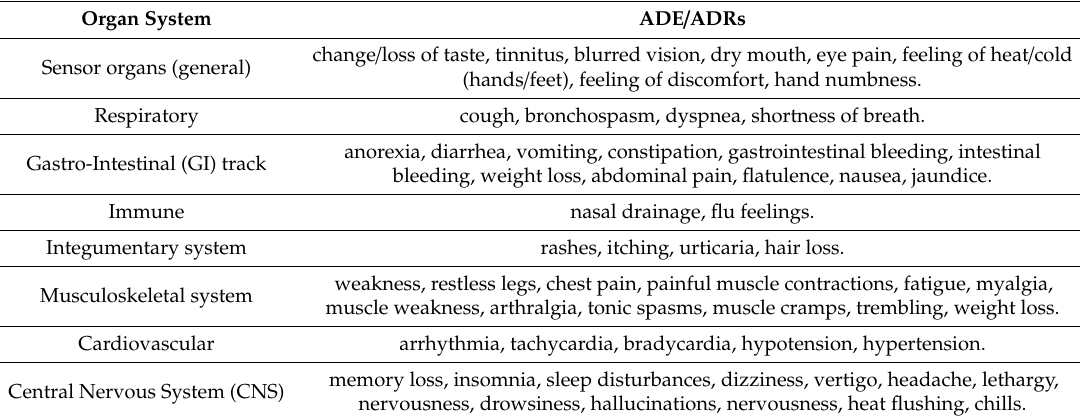
Table 2. ADE / ADRs that are included in the study and included in Greek National Formulary and drugs’